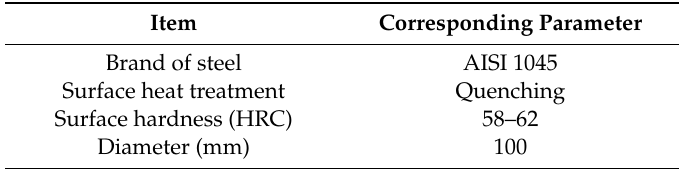
Figure 12. Actual figuring and measuring equipment of the experimental shaft: ( a ) modified lathe; ( b ) Talyrond TM 565H cylindricity meter. Table 2. Characteristics of the experimental shaft.